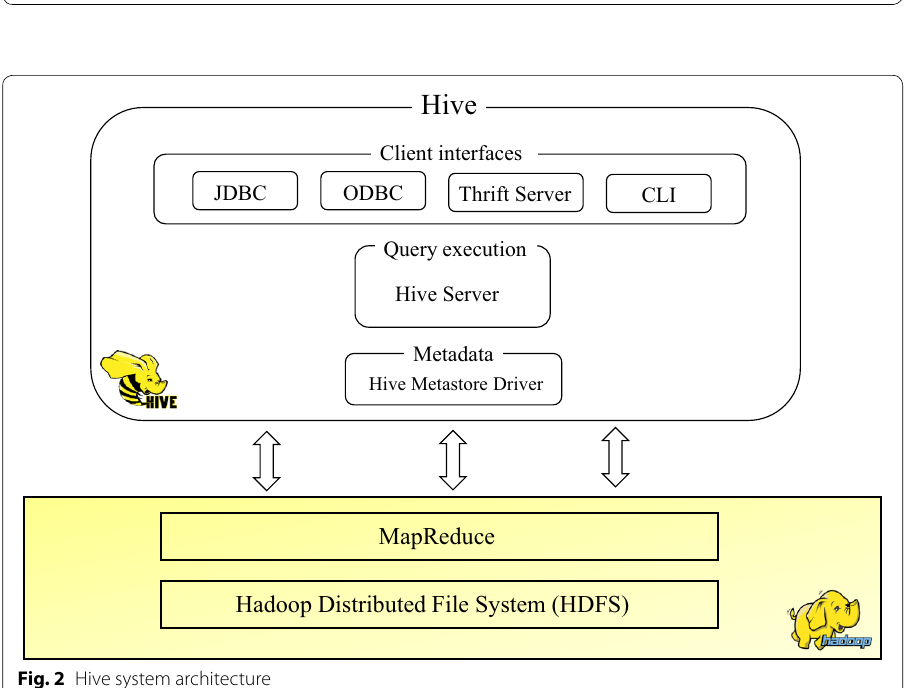
Fig. 1 MapReduce‑based HLQL architecture and their position on top of